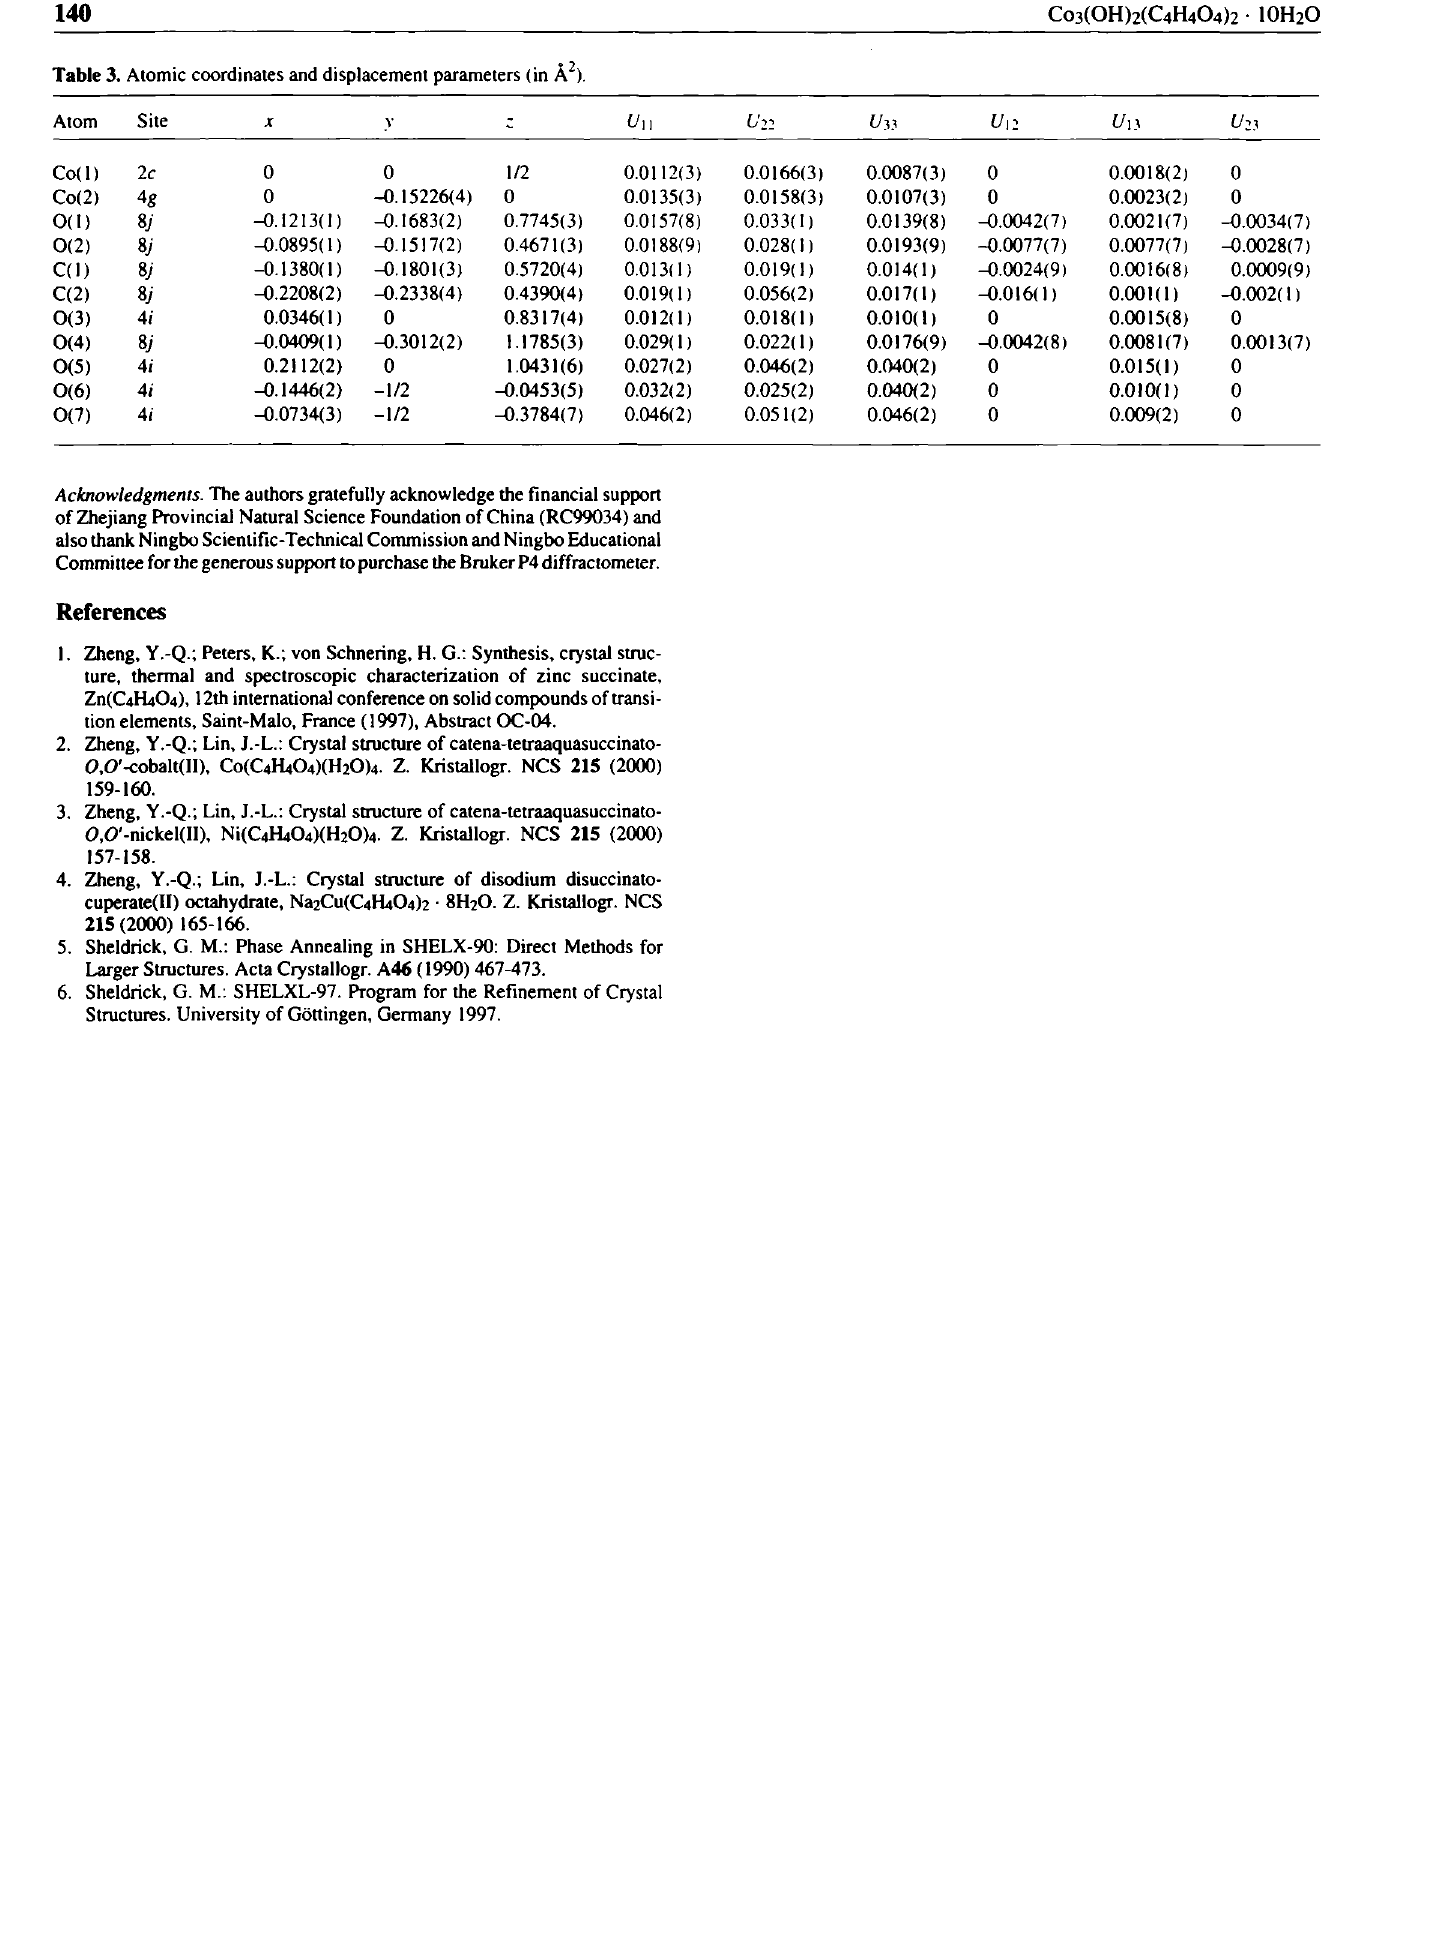
Table 3. Atomic coordinates and displacement parameters (in Ä 2